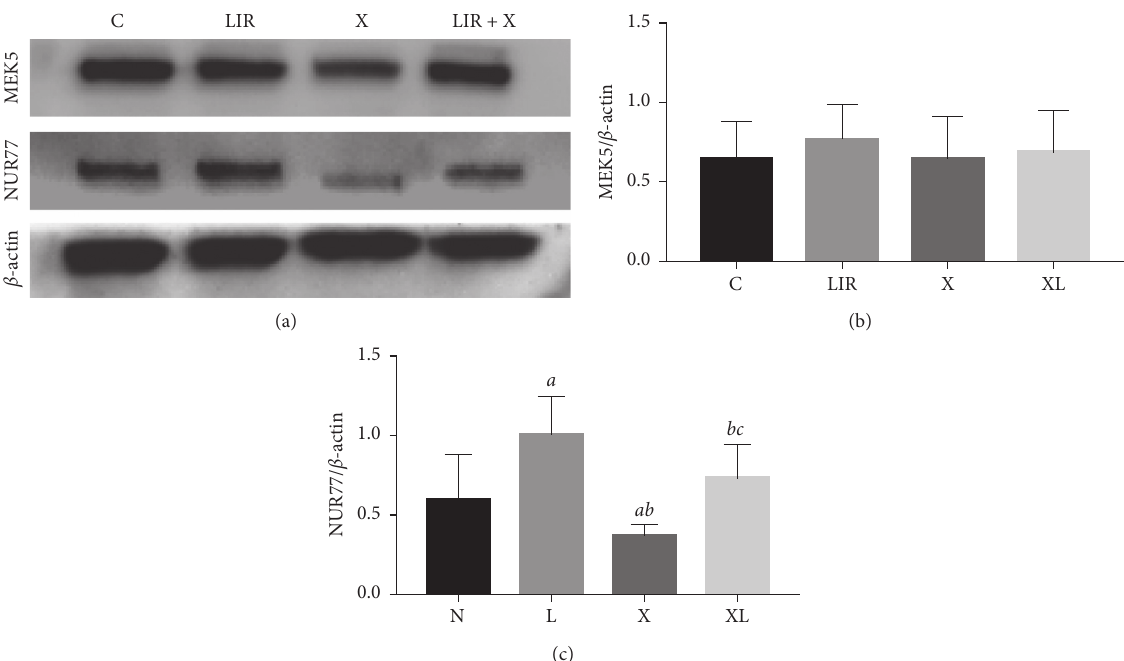
Figure 8: XMD8-92 inhibited the activity of the ERK5 signaling pathway. The protein expression of MEK5 and NUR77 was detected by western blot after the MC3T3-E1 cells were pretreated with 10 μ M XMD8-92 for 1h followed by 100nM liraglutide treatment for 48h (a). Quantitative analysis of the protein level of MEK5 (b) and NUR77 (c) in MC3T3-E1 cells after being pretreated with 10 μ M XMD8-92 for 1h followed by 100nM liraglutide treatment for 48h, aP < 0.05 compared with control, bP < 0.05 compared with 100nM liraglutide, and cP < 0.05 compared with XMD8-92 group. C: control group; LIR: 100nM liraglutide; X: XMD8-92, X +LIR: XMD8-92 with 100nM